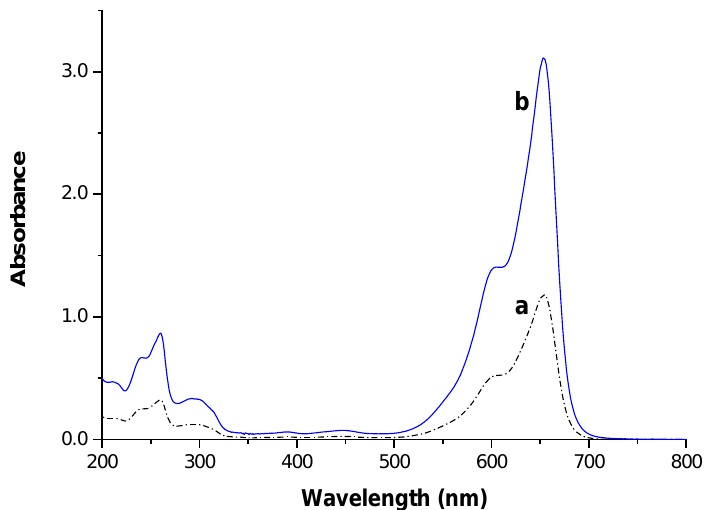
Figure 2. UV – Vis spectrum of C.I. Basic Blue 3 (M r = 359.89) in aqueous solution: ( a ) 0.8 × 10 − 2 g L − 1 ; ( b ) 2 × 10 − 2 g L − 1 .